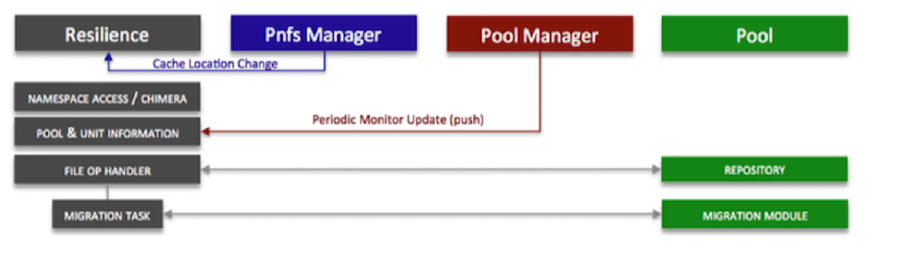
Figure 1. dCache Resilience: inter-component interaction (new file